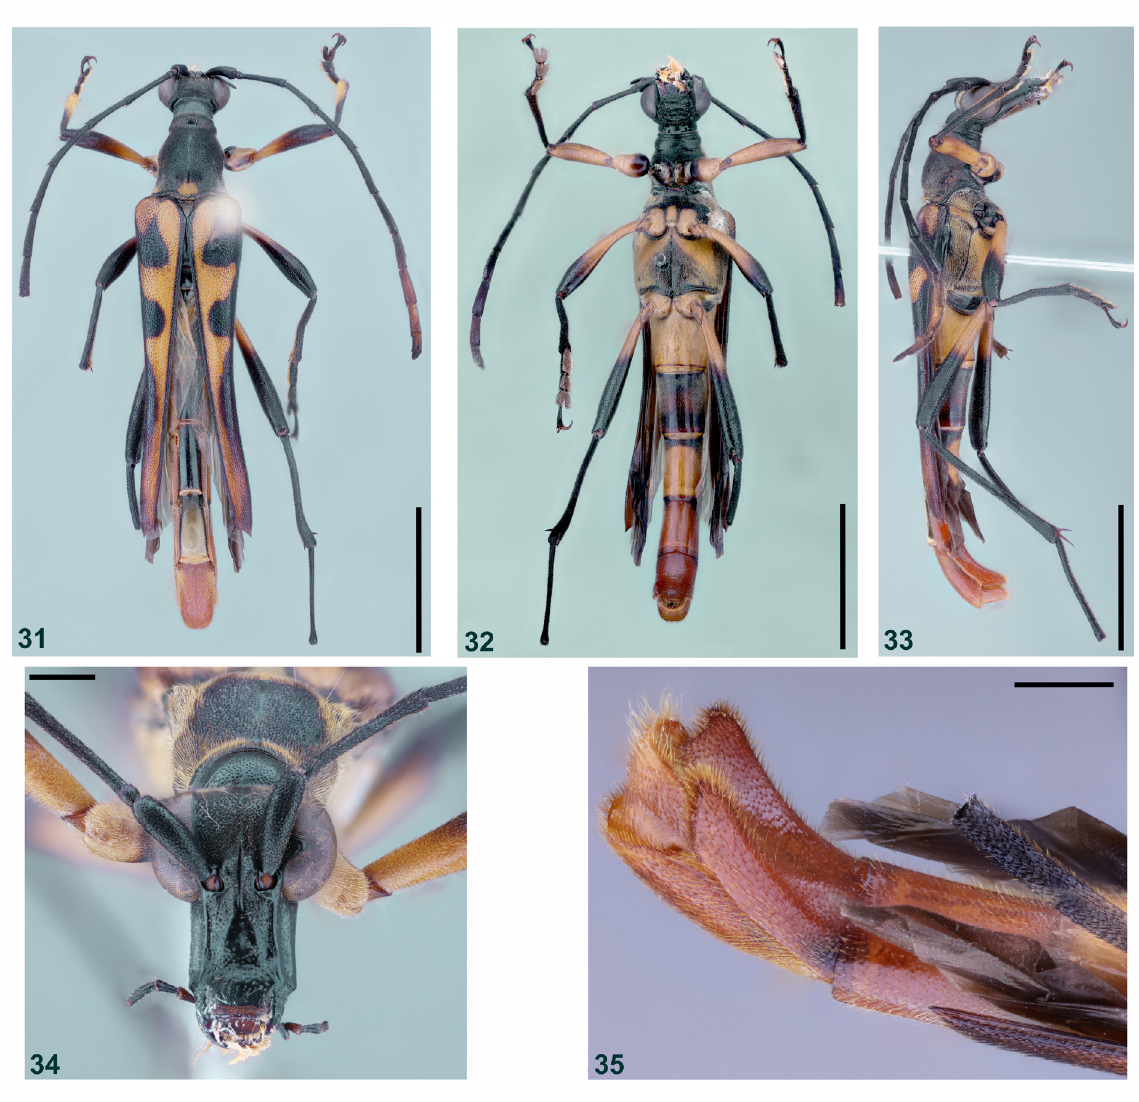
Figs 31–35. Strangalia lunai sp. nov., holotype, ♂ (RBINS 34.248). 31 . Habitus, dorsal view. 32 . Habitus, ventral view. 33 . Habitus, lateral view. 34 . Head, frontal view. 35 . Apex of abdomen. Scale bars = 1.0